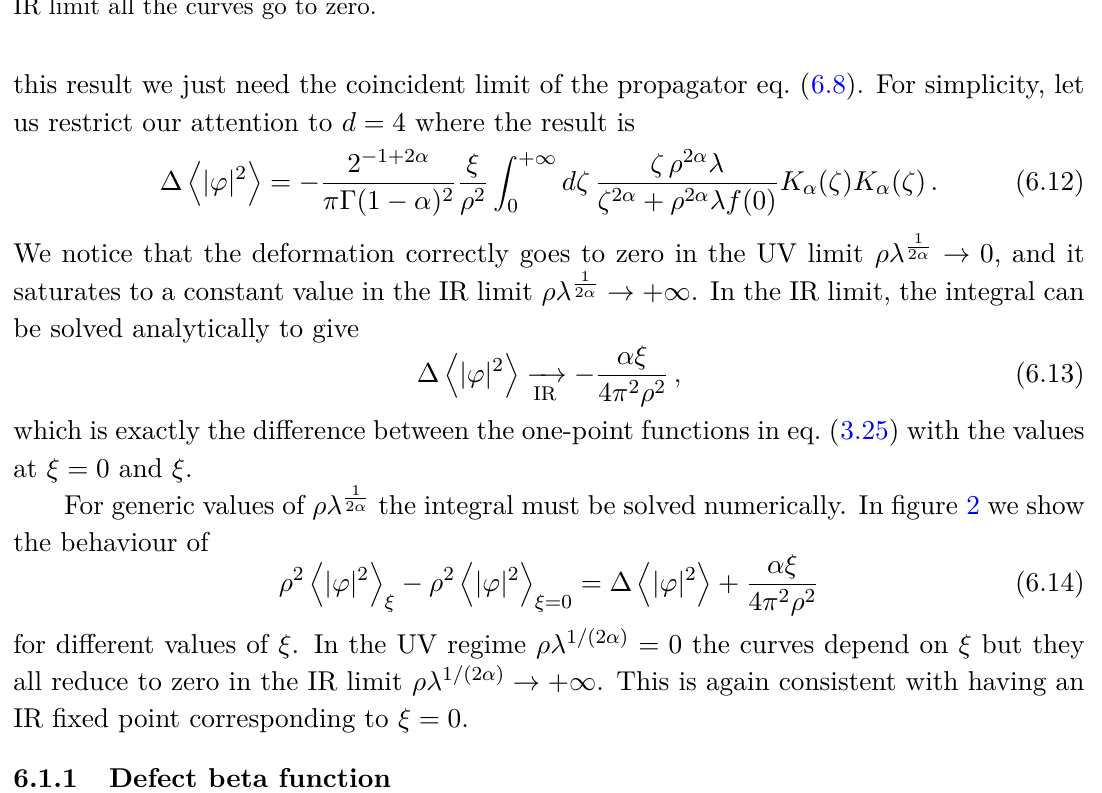
Figure 2. The quantity ρ 2 for d = 4 , α = 0 . 75 , and different values of ξ . While in the UV the quantity depends on ξ , in the IR limit all the curves go to